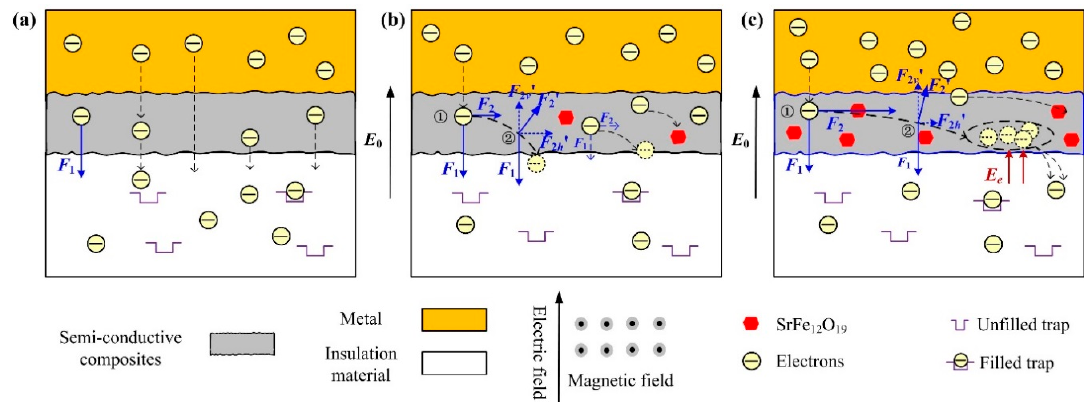
Figure 10. Schematic diagram of electron moving path in the semi-conductive layer under the combined action of electric field and magnetic field. ( a ) Without SrFe 12 O 19 in the semi-conductive layer; ( b ) low SrFe 12 O 19 content in the semi-conductive layer; and ( c ) high SrFe 12 O 19 content in the semi-conductive layer.